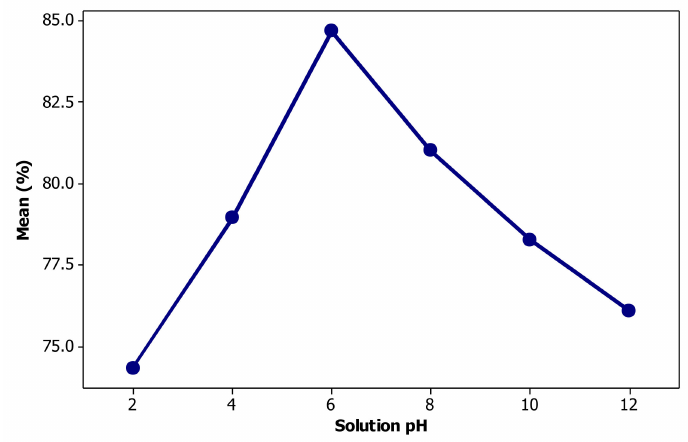
Figure 8. Effect of solution pH on the performance of chromium